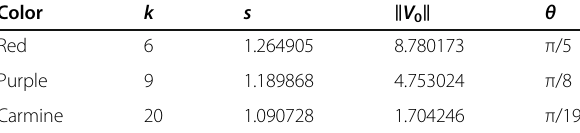
Table 2 The specific data of typical curve for Example 2 k